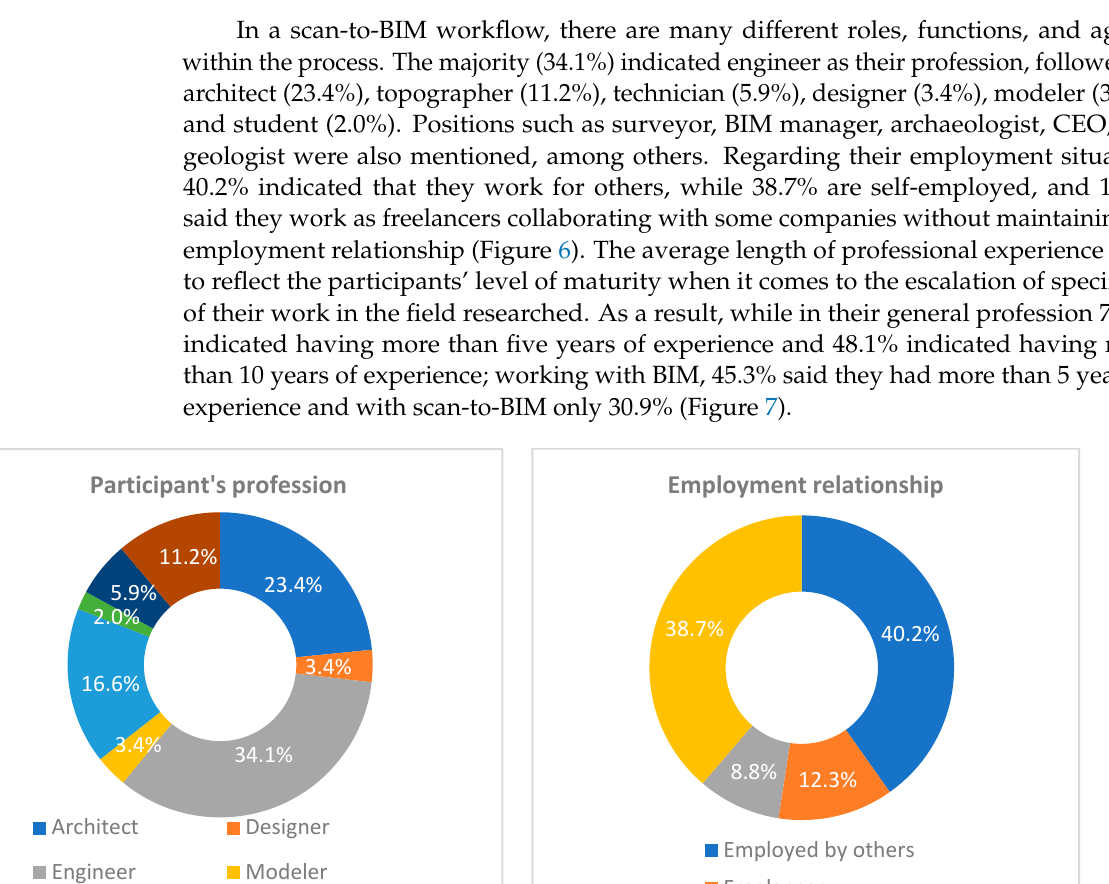
Figure 5. Graphs with the survey sample profile: ( a ) Participant’s age, ( b ) Participant’s gender.